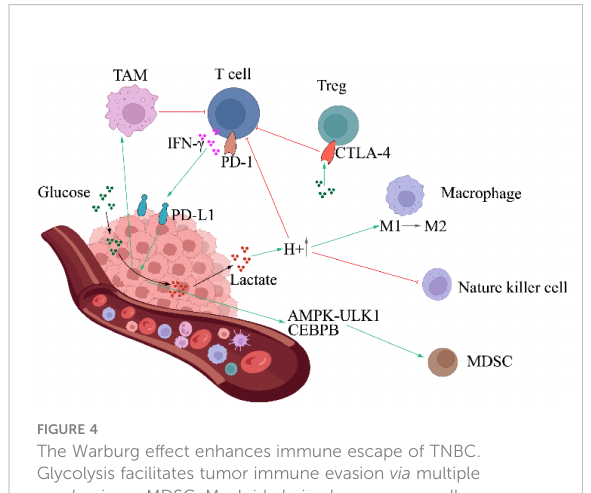
FIGURE 4 The Warburg effect enhances immune escape of